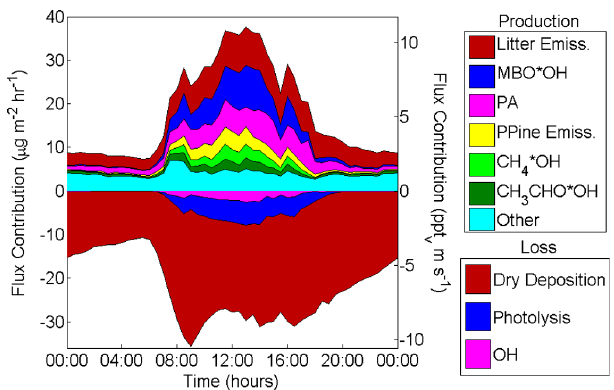
Fig. 5. Diurnal medians of contributions to HCHO flux in the base case model.